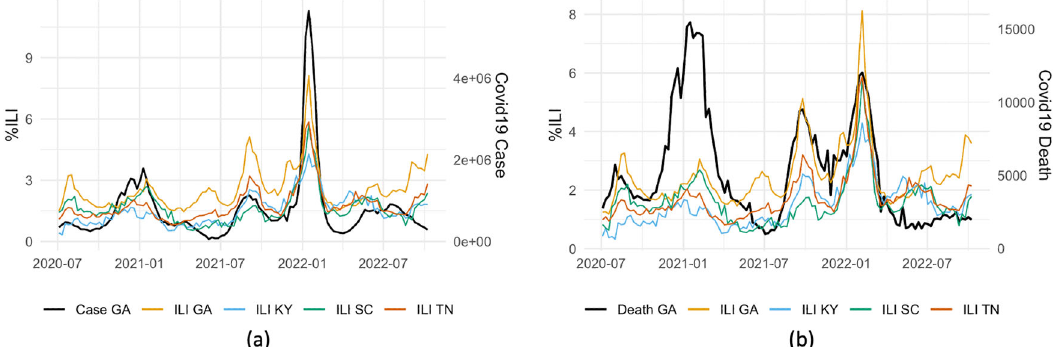
Fig. 1 Illustration of Georgia (GA) ’ s real-time COVID-19 cases/deaths (black) growth in comparision with its own lagged %ILI (yellow) and the lagged %ILI of the neighboring states, from 2020-07-04 to 2022-08-13. a COVID-19 real-time cases in GA (thick black curve) vs. lagged 1 week %ILI in GA (yellow curve) and the neighboring states; ( b ) COVID-19 real-time deaths in GA (thick black curve) and lagged 3 weeks %ILI in GA (yellow curve) and the neighboring states. The underlying data is found in Supplementary Data